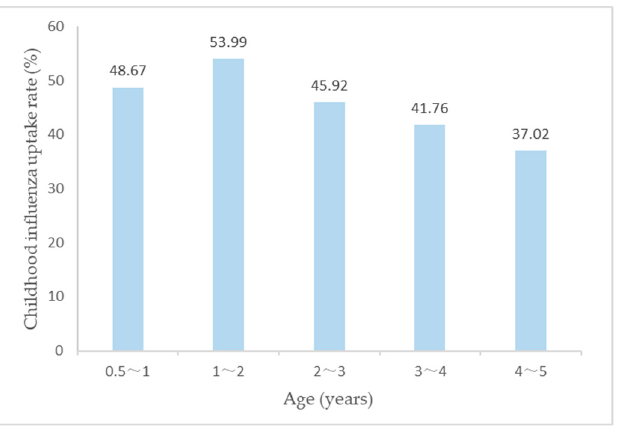
Figure 1. The Influenza vaccination uptake rates among children of each age group in three provinces.